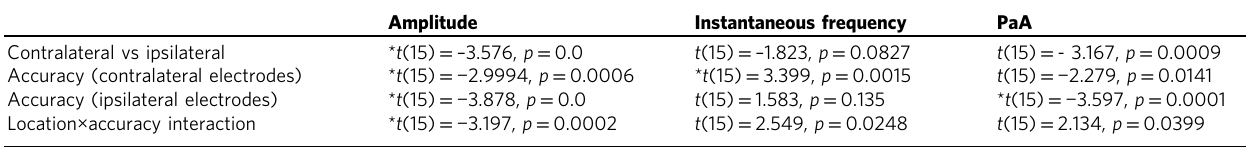
Table 2 Amplitude, Frequency and PaA are modulated by experimental conditions